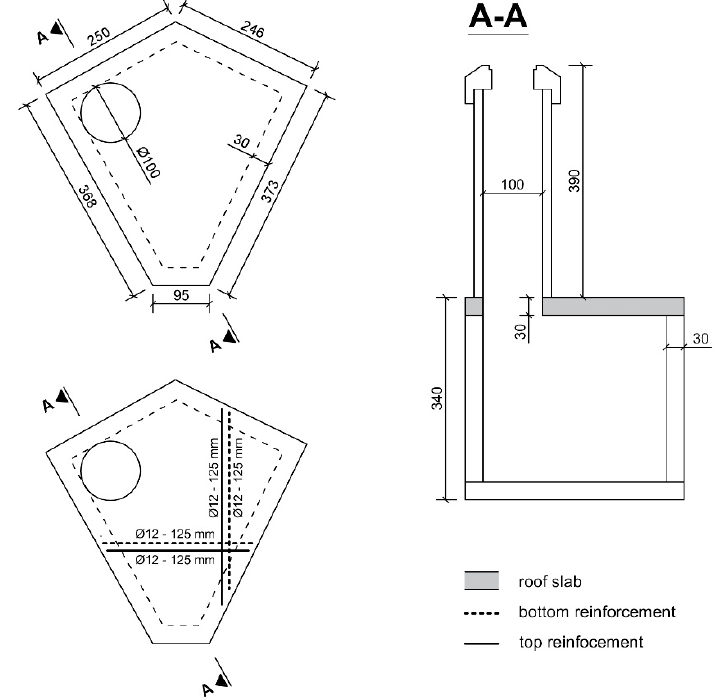
Figure 2. Top view with dimensions of the roof slab (top left). Top view with principle top and bottom reinforcement of the roof slab (bottom left). Side view of the inspection chamber with the roof slab highlighted. (dimensions are in mm).